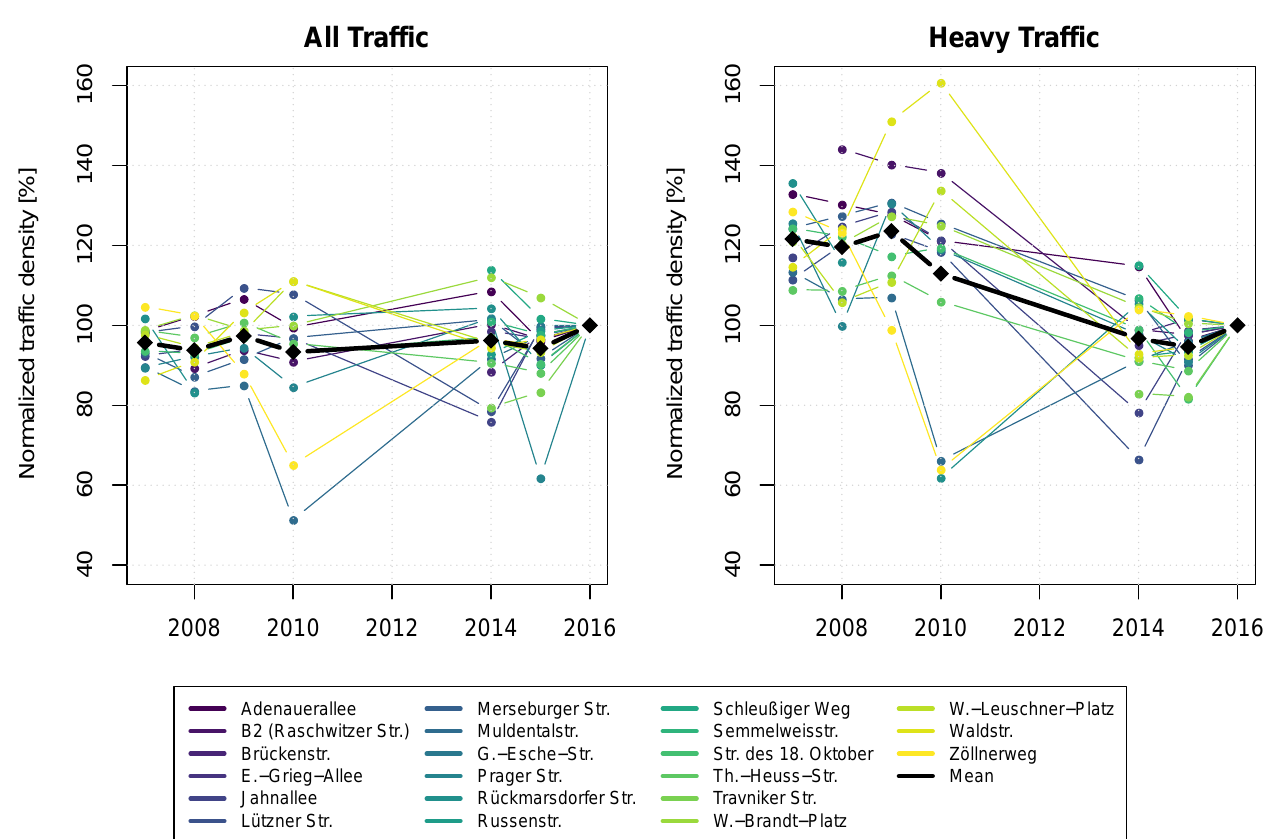
Figure A1. Change of the traffic density of various counting stations within the city of Leipzig, normalized to the year